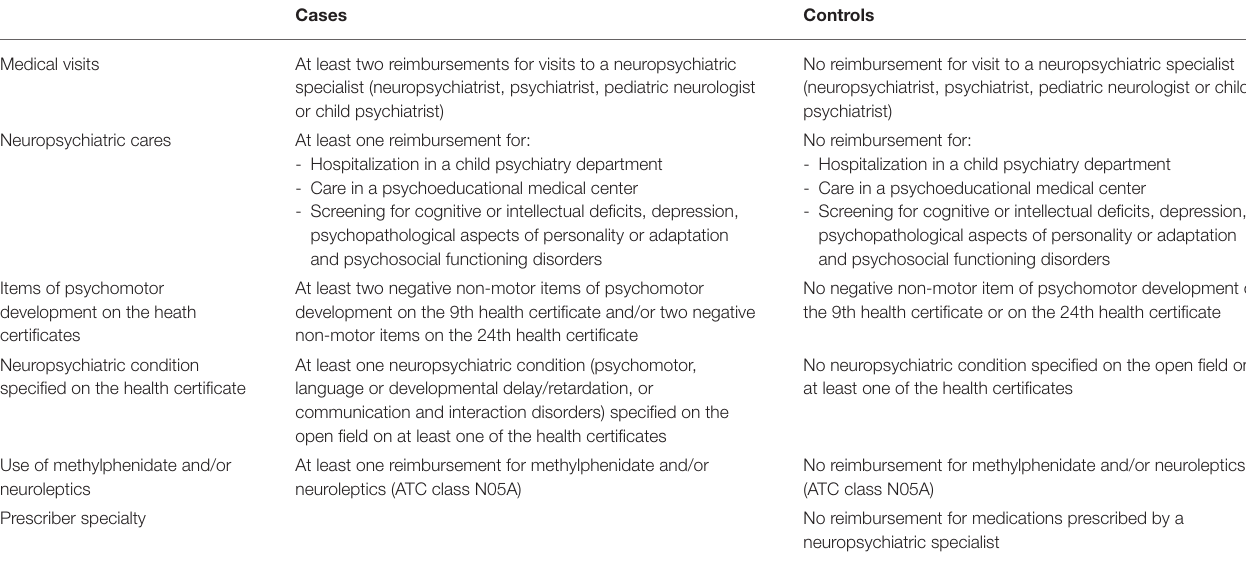
TABLE 1 | Selection criteria for the case and control